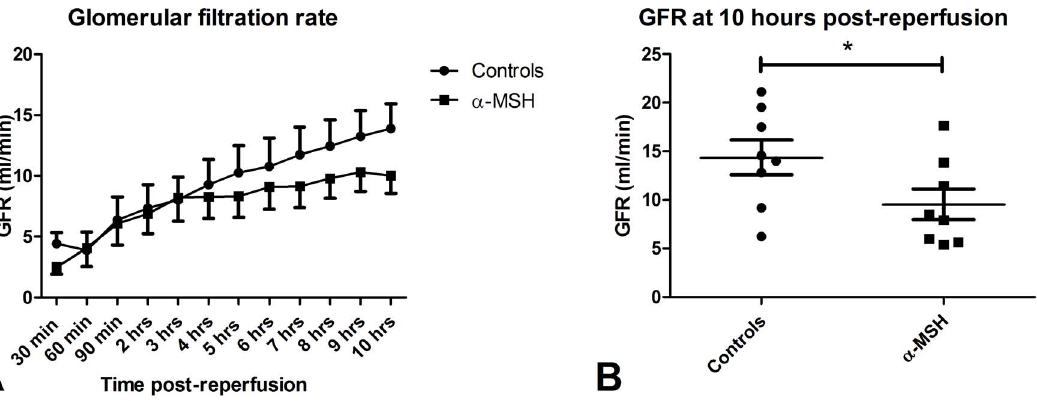
Figure 3. Effect of a -MSH on GFR. Figure 3A shows the recovery of renal function during follow-up of ten hours. At ten hours post-reperfusion a - MSH significantly reduced GFR (Figure 3B; *=p , 0.05).